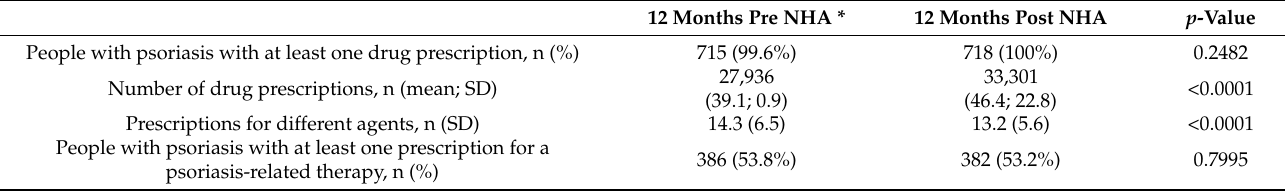
Table 7. General information on drug therapy (N = 718) in people with psoriasis before and after nursing home admission